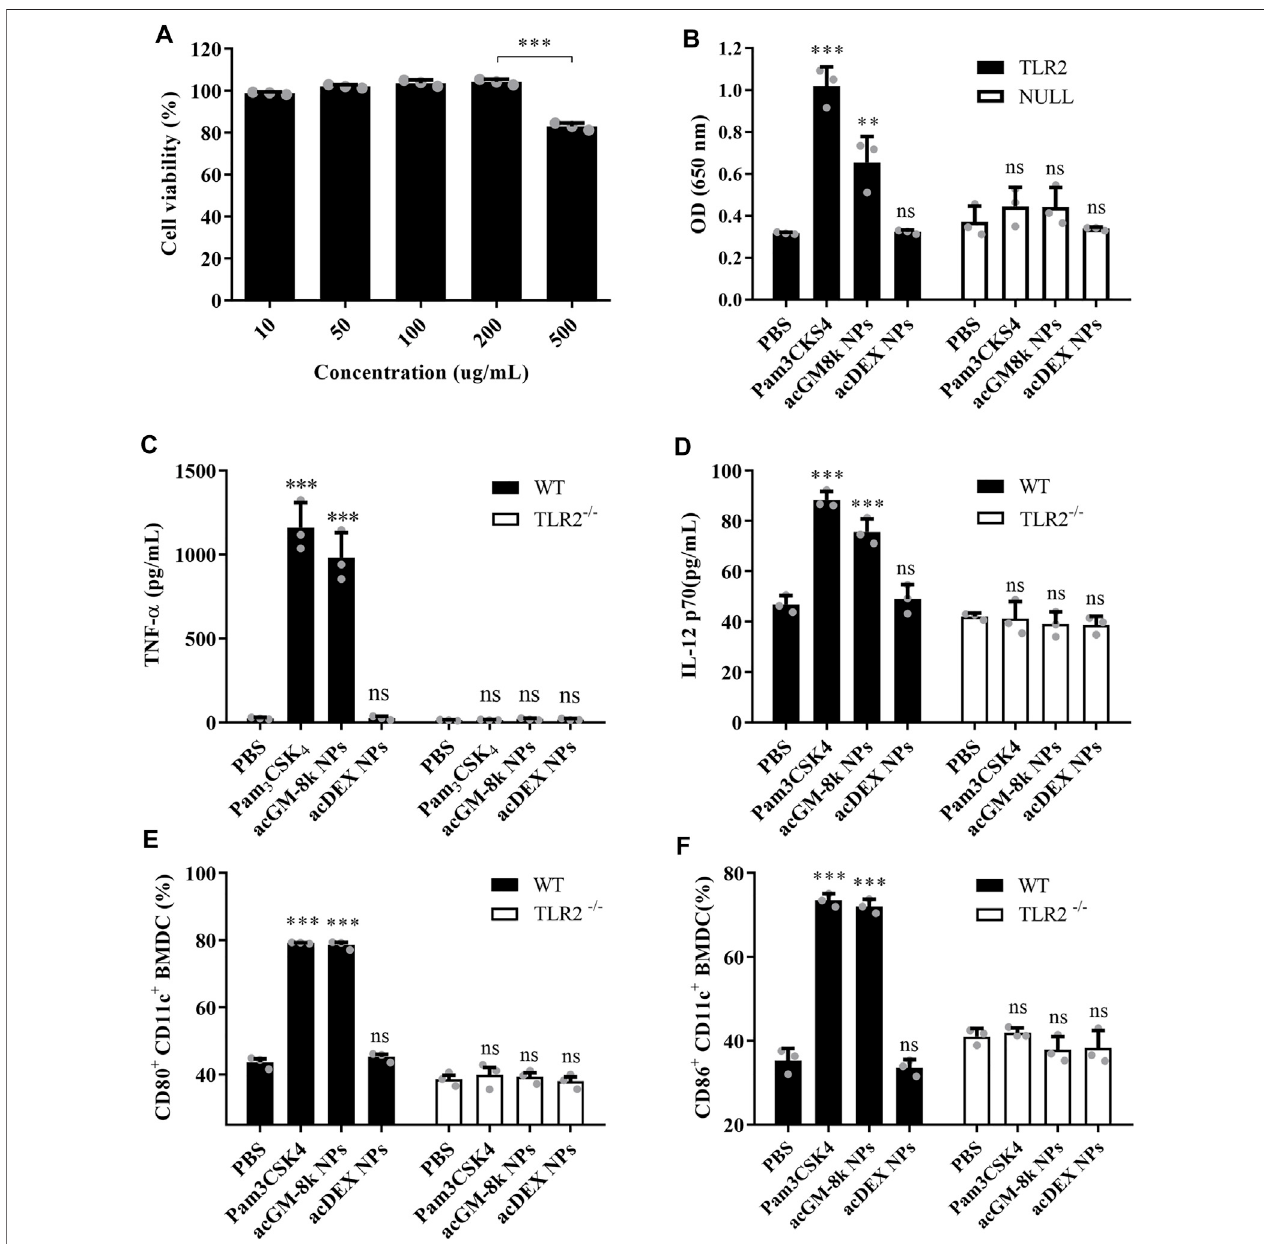
FIGURE4| acGM-8kNPsactivateBMDCsthroughTLR2 invitro . (A) CellviabilityofacGM-8kNPsatdifferentconcentrations. (B) Detectionofsecretedembryonic alkaline phosphatase (SEAP) activity in TLR2 reporter cell (murine TLR2-expressing HEK 293 cells, Invivogen). HEK-Blue ™ Null2 Cells were used as a negative control. (C – D) Determination of cytokines (C) TNF- α and (D) IL-12p70 secreted by BMDCs isolated from TLR2 − / − mice or WT mice. (E – F) Percentage of (E) CD80 + and (F) CD86 + in CD11c + cells isolated from TLR2 − / − mice or WT mice. TLR2 − / − : TLR2 knockout. WT: wild type. * p < 0.05; ** p < 0.01; *** p < 0.001 vs the PBS treatment; ns: no signi fi cance; n = 3: For (A) and (B) , data were obtained from three replicates of one representative experiment out of three; for (C) – (F) , data were obtained from three mice in each group. All numerical values are given as average values ± standard deviation. Statistical analysis was performed using Prism Software (GraphPad, United States), followed by one-way ANOVA analysis with Dunnett ’ s post hoc